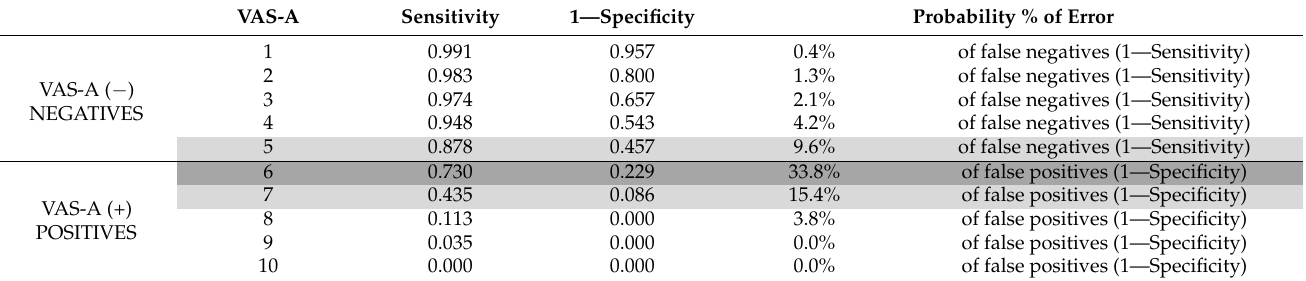
Table 5. ROC curve coordinates for sensitivity, specificity, and probability of error.